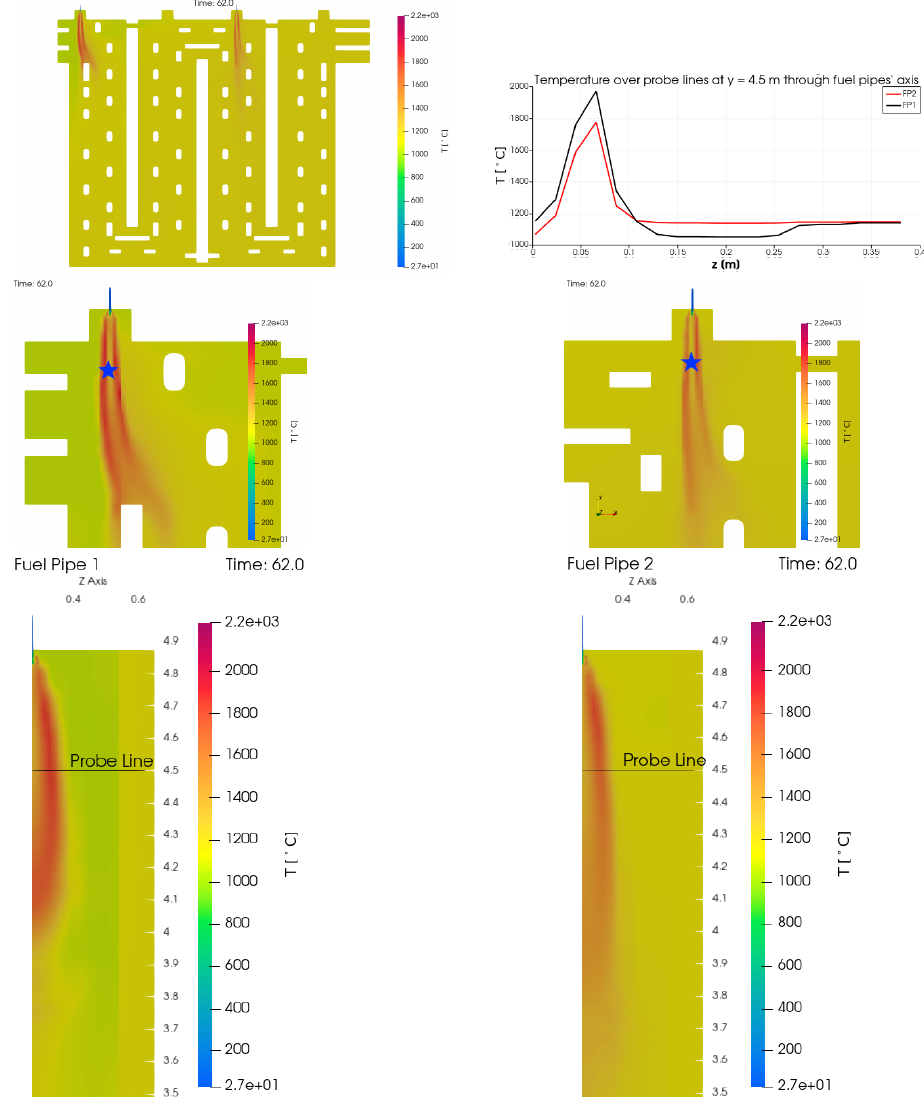
Figure 6. Temperature (in degrees Celcius) on the symmetry plane ( top left ), on probe lines through the flame ( top right ), at the outlet of Burner-1 on the symmetry plane ( middle left ), at the outlet of Burner-2 on the symmetry plane ( middle right ), on the plane through Burner-1 perpendicular to the symmetry plane ( bottom left ) and on the plane through Burner-2 perpendicular to the symmetry plane ( bottom right ). Values at t = 62s of computation time are